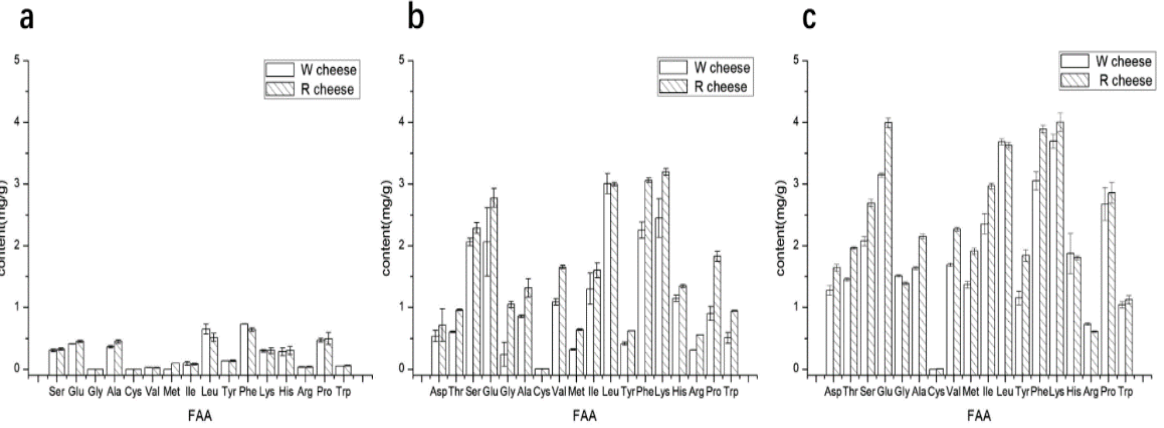
Figure 2. Content of individual free amino acid (FAA) of cheeses with different ripening time. ( a ) 0 d; ( b ) 16 d; ( c ) 40 d.